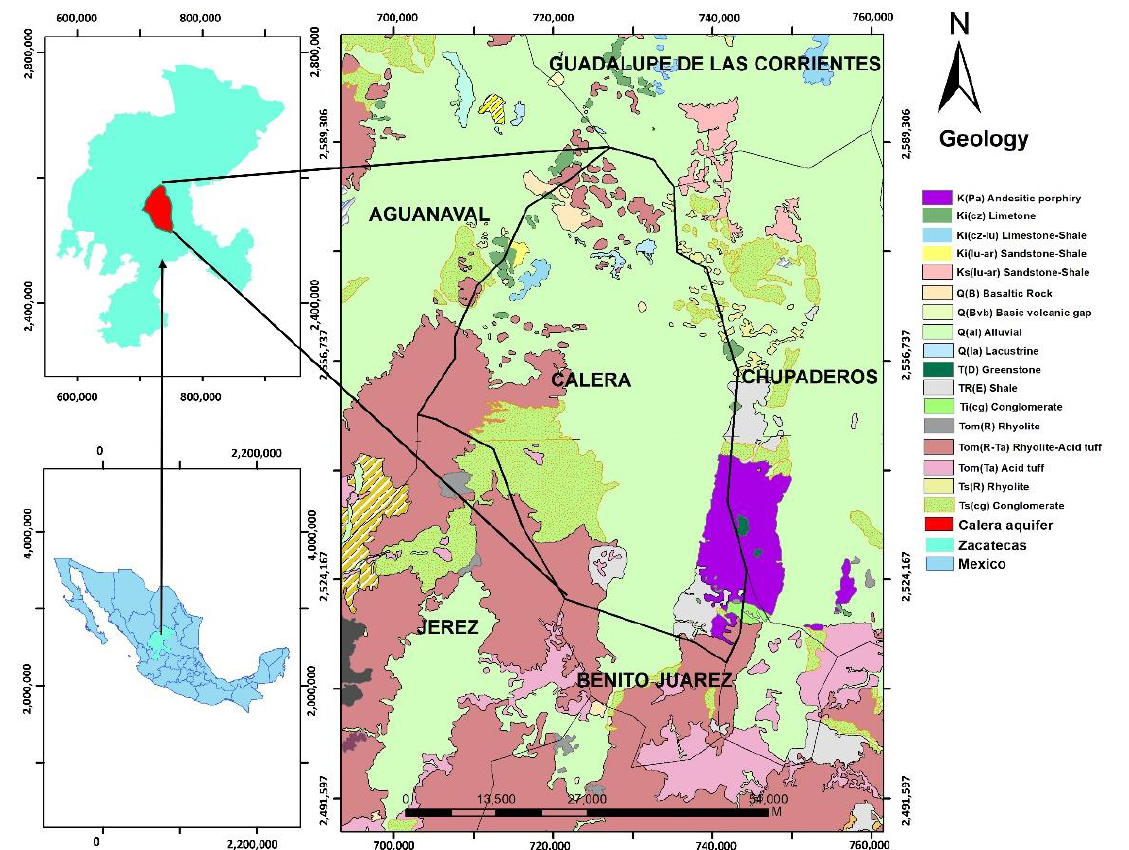
Figure 1. Geological map and location of the Calera administrative aquifer.